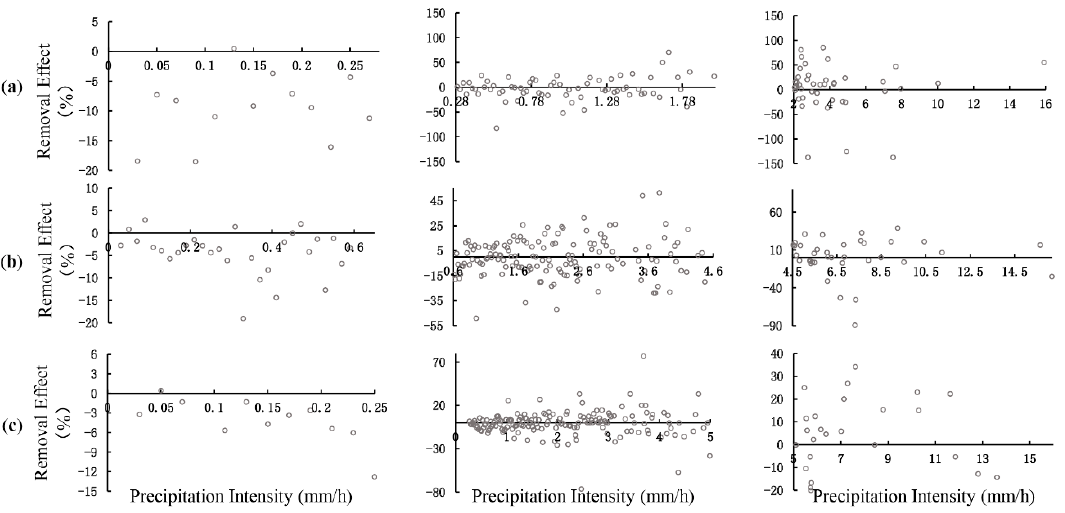
Table 1. Sample percentage with positive, neutral, and negative removal effect for three equal-sample bins of precipitation intensity in the BTH, YRD, and PRD regions. BTH